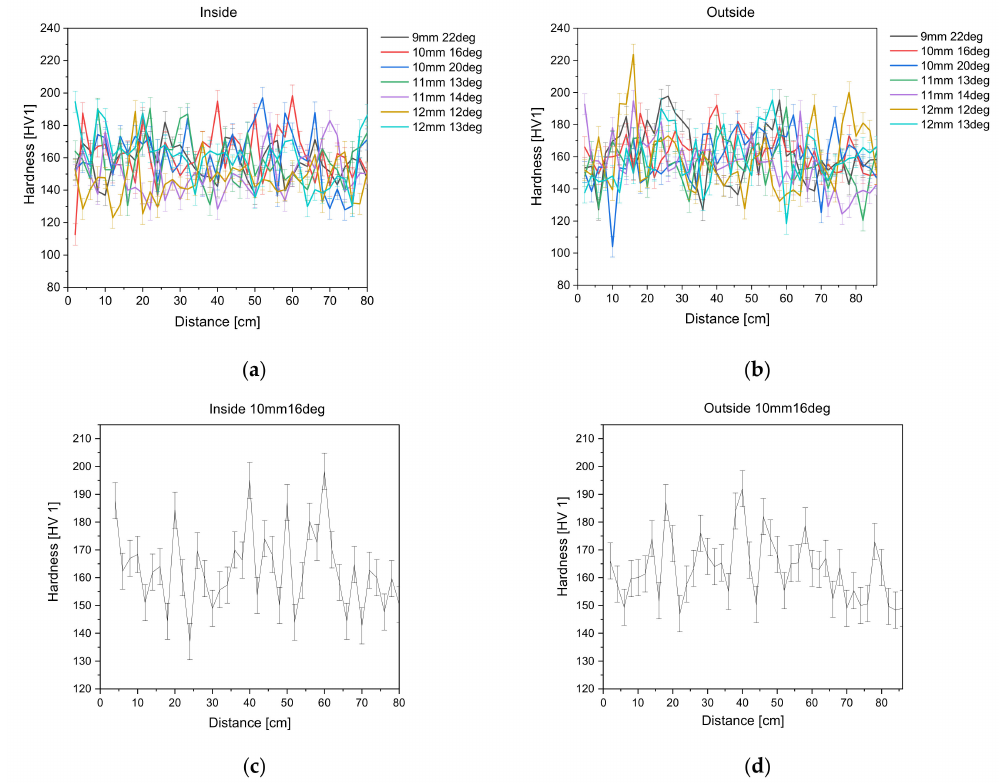
Figure 6. Development of HV 1 hardness total along the ( a ) inside and ( b ) outside of the non-tangentially bent tubes (treated surface). ( c ) Development of HV 1 hardness for non-tangentially bent tube 10 mm 16 deg inside ( d ) and outside.